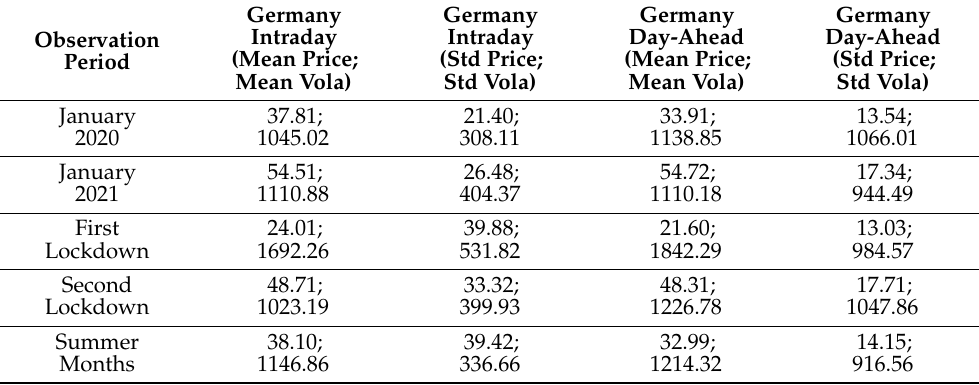
Table 4. General Statistics about German Prices and Volatilities in EUR. Observation